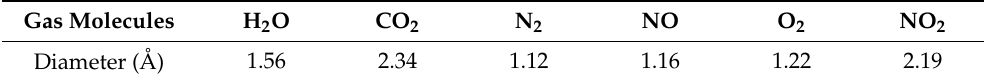
Table 3. Summary of the diameters of gas molecules after geometry optimization by the SCC-DFTB method.